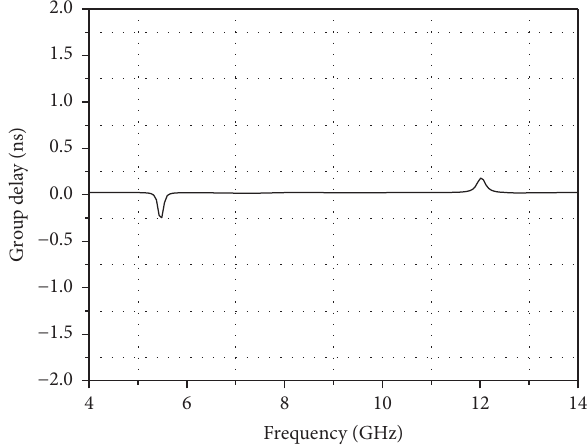
Figure 16: Group delay for the proposed defected substrate wide- band